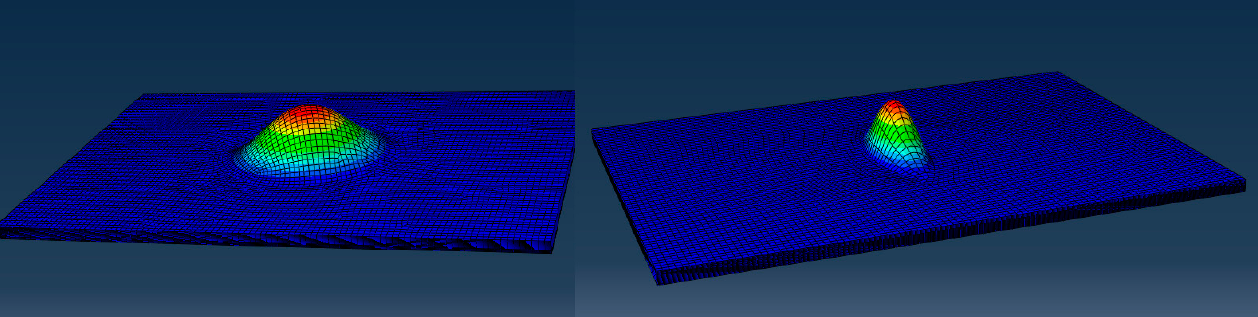
Figure 20. Eigen-solution results for the two different elliptical damage shapes, one (38 × 10) between the 4th and 5th ply and the other one (31 × 36) between the 12th and 13th ply.